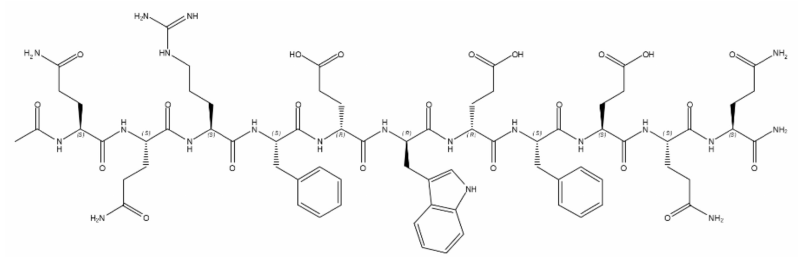
Figure 6. Chemical structure of PF 11 -4.